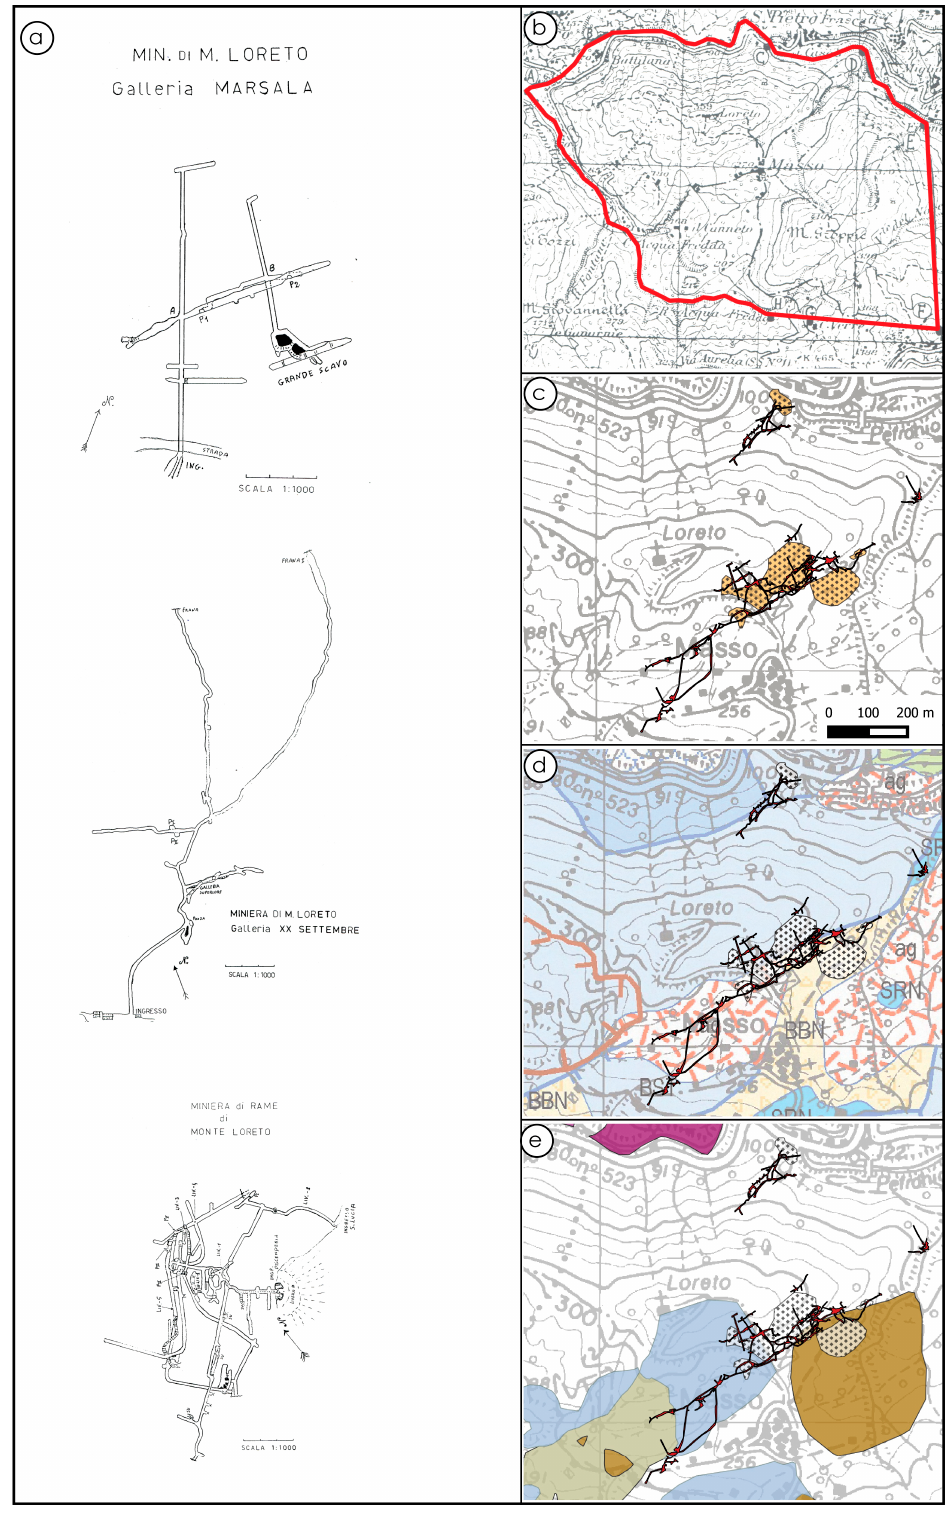
Figure 4. Historical mining maps overlaid to thematic cartography by means of open source QGIS software. ( a ) Historical maps illustrating the underground galleries of M. Loreto Mine [45]; ( b ) historical perimeter of the M. Loreto mining concession; ( c – e ) overlay of historical mine galleries and regional topographic map ( c ), local geology ( d ), and landslides map ( e ).